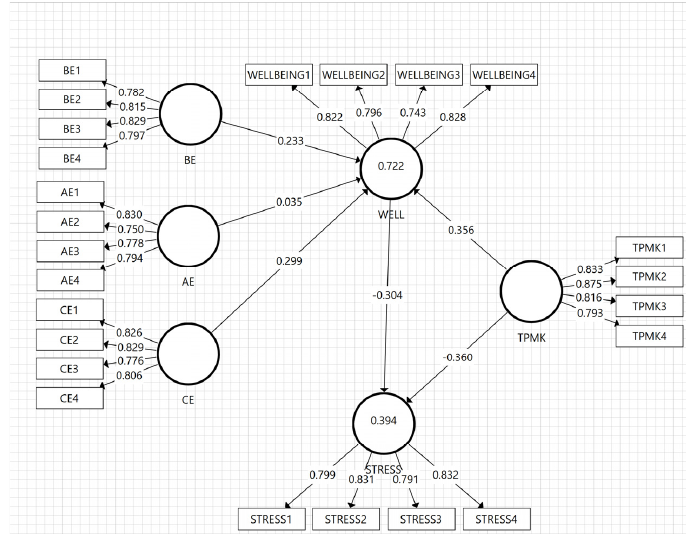
Figure 2. The outer loadings and R 2 values. Note: AE: affective engagement, BE: behavior engage- ment, CE: cognitive engagement, WELL: well-being, and TPMK: Technological Pedagogical Math- ematical Knowledge.